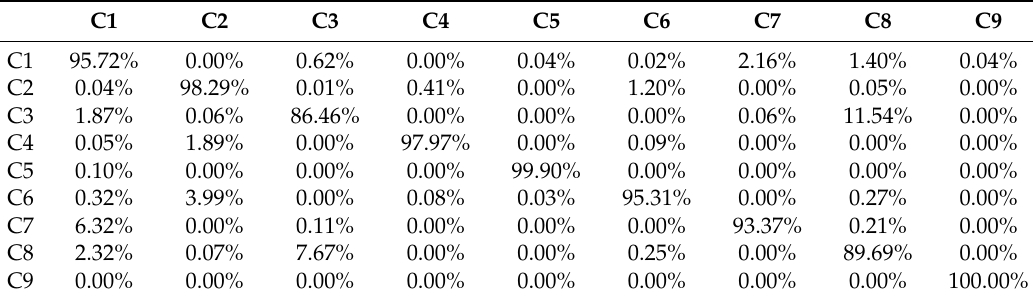
Table 7. The detailed classification accuracy of all the classes for Pavia University